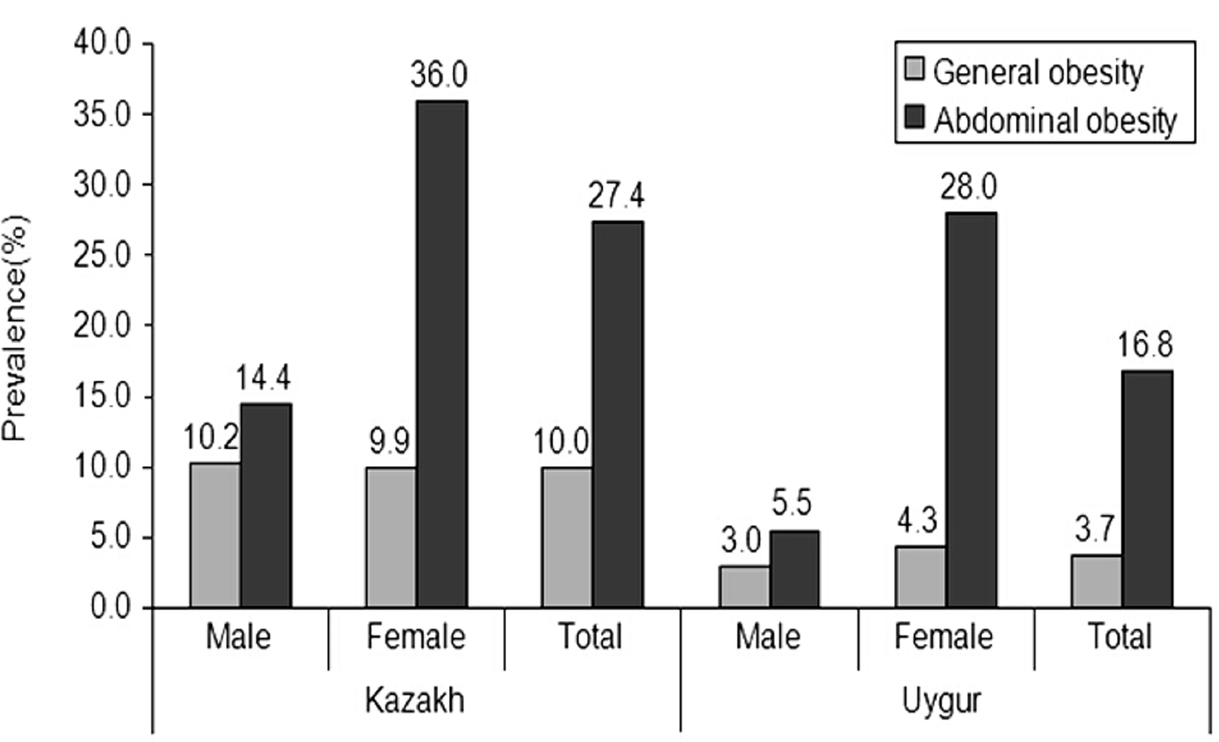
Figure 1. Prevalence of general obesity and abdominal obesity in rural Kazakh and Uyghur adult men and women based on the WHO Criteria. (General obesity: BMI $ 30 kg/m 2 ; Abdominal obesity: WC $ 102 cm for men, and $ 88 cm for women).